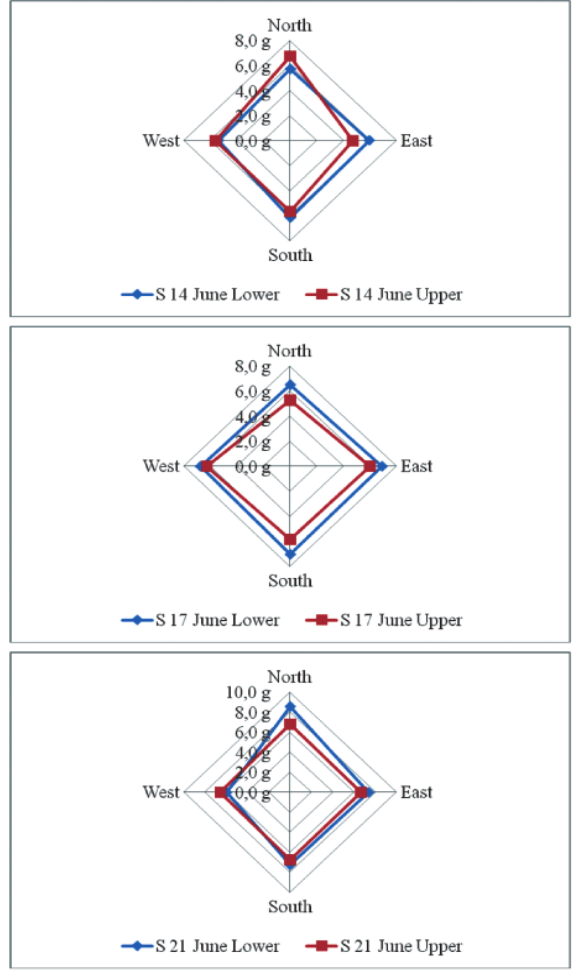
Fig. 7: The mass in the function of time, orientation and height in the case of Germersdorfi [g]